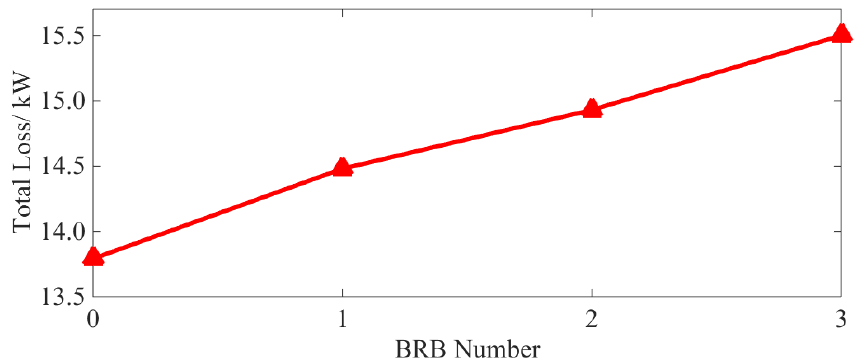
Figure 12. Characteristic curve of total loss.